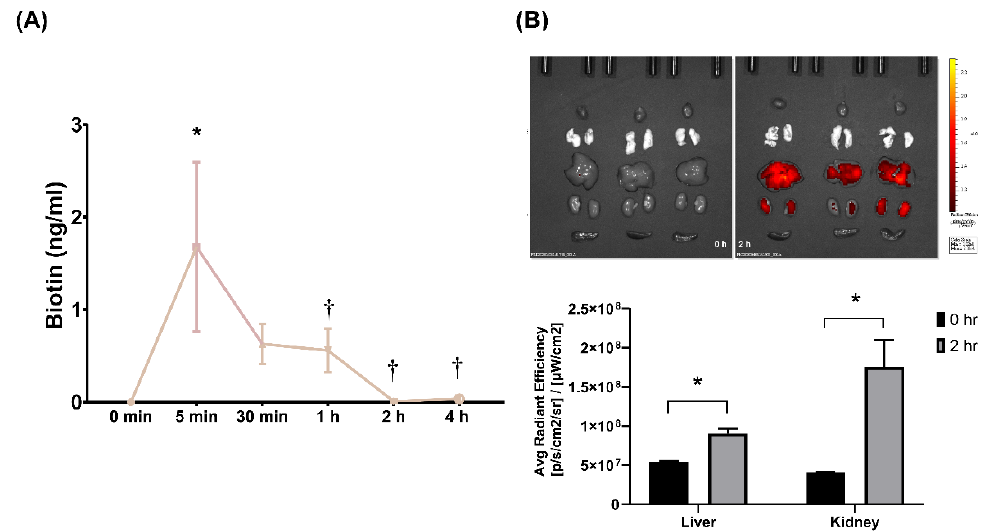
Figure 1. Pharmacokinetics and biodistribution of SEM18 peptide. ( A ) Pharmacokinetic analysis of SEM18 peptide. A single dose of biotin-conjugated SEM18 peptide (0.3 mg / kg) was administered. The plasma concentrations of SEM18 peptide were determined via measuring plasma biotin concentrations using enzyme-linked immunosorbent assay (ELISA), as measured at 0 min (baseline), 5 min, 30 min, 1 h, 2 h, and 4 h after intraperitoneal (i.p.) administration of SEM18 peptide; ( B ) Biodistribution of SEM18 peptide, as measured at 0 h (baseline) and 2 h after i.p. administration using ex vivo bioluminescence imaging assay. Data are presented as the mean ± standard deviation. Data of pharmacokinetics and biodistribution were derived from three mice at each time point. * p < 0.05 vs. the baseline value; † p < 0.05 vs. the value measured at 5 min after administration.